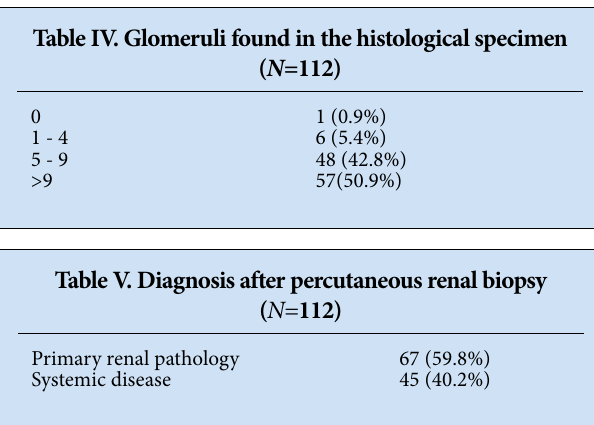
Table III. Complications ( N= 112)